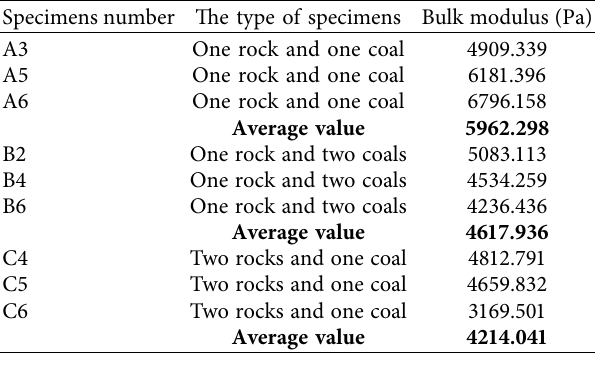
Table 2: The bulk modulus of specimen with different gangue ratio.